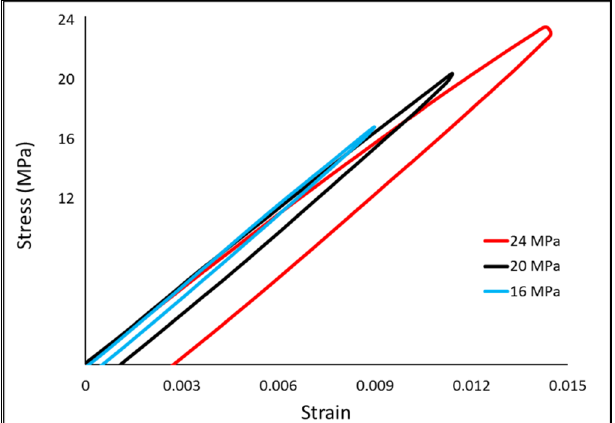
Figure 16. The hysteresis loops for SAC305 joints cycled with different stress amplitudes at no dwelling.